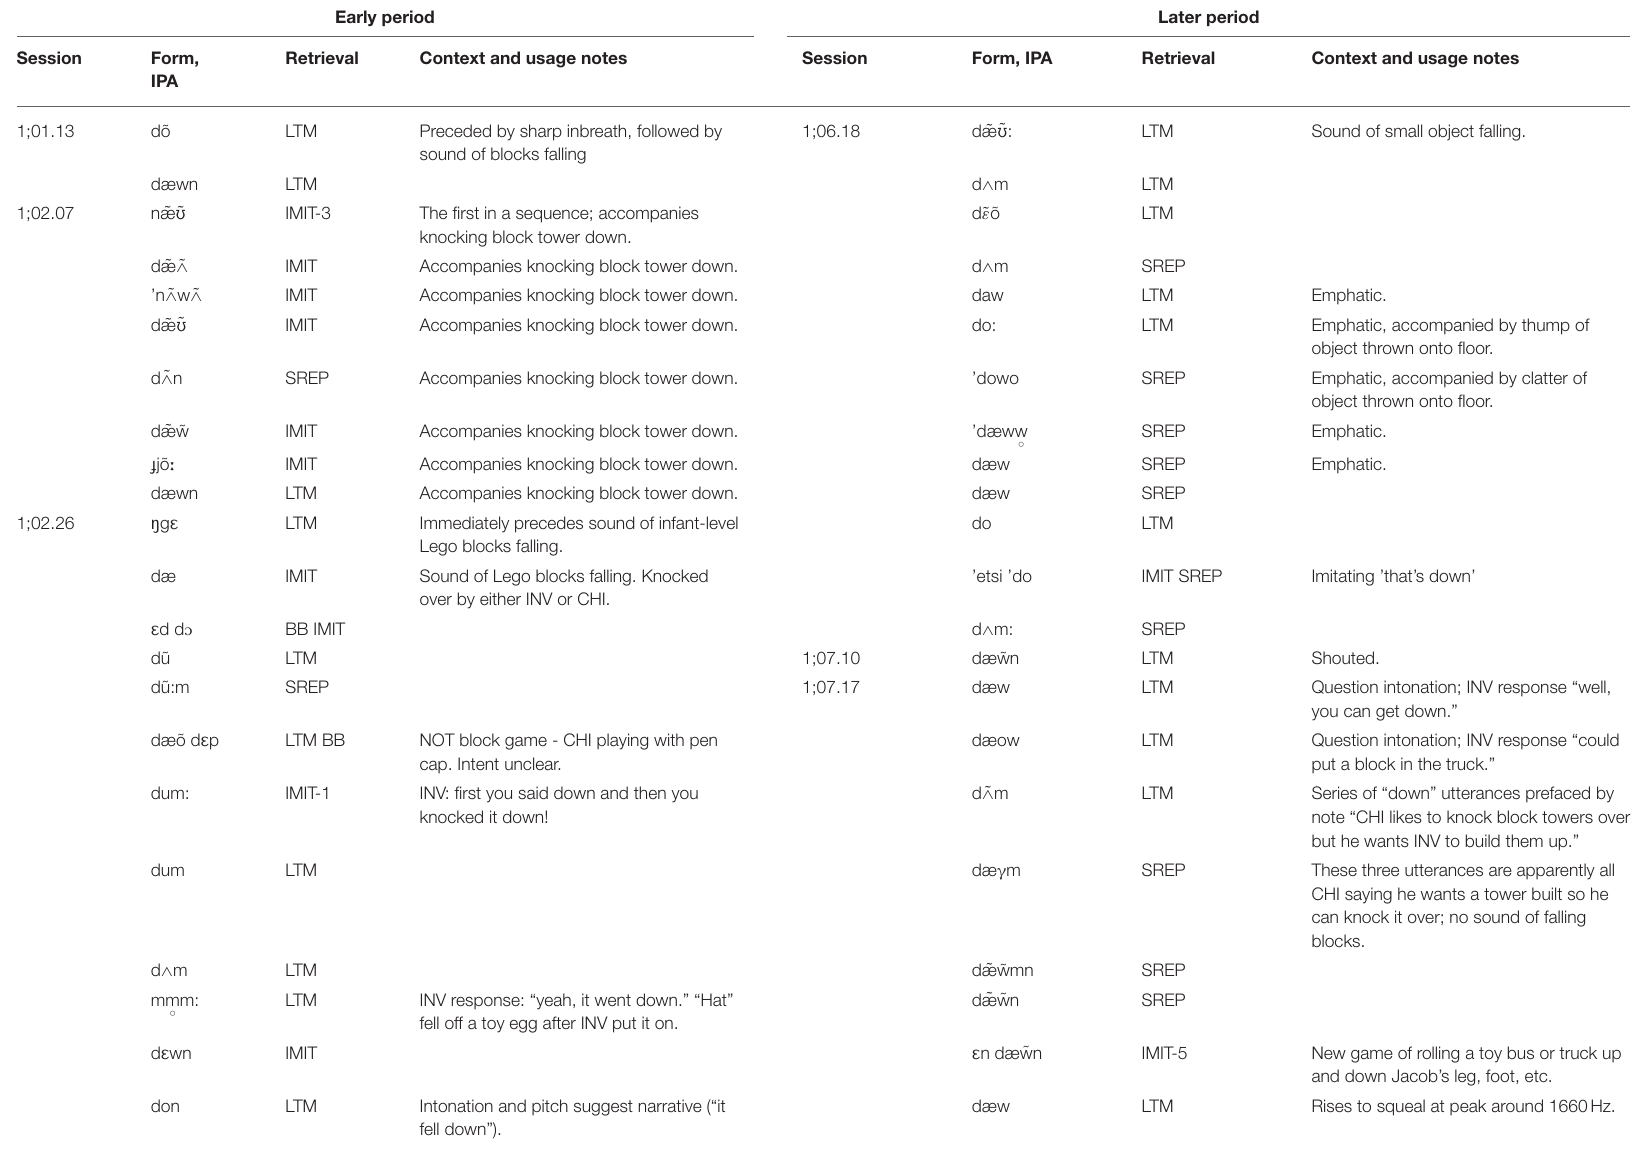
TABLE 1 | Representative forms and uses of “down” over 6